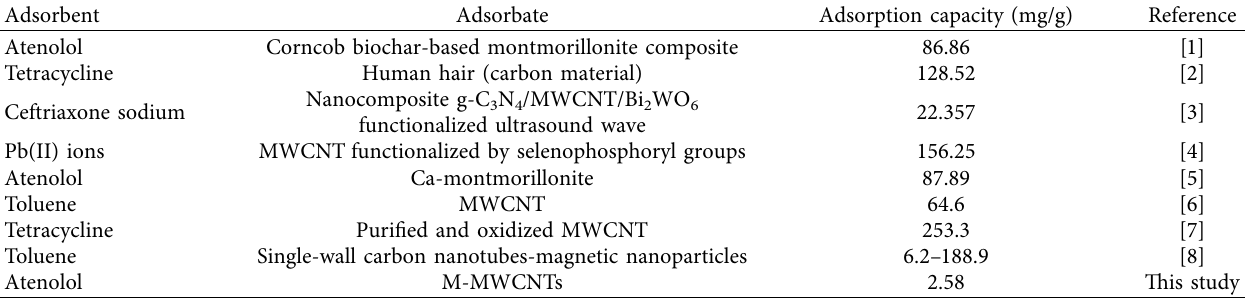
Table 8: Summary of similar studies.